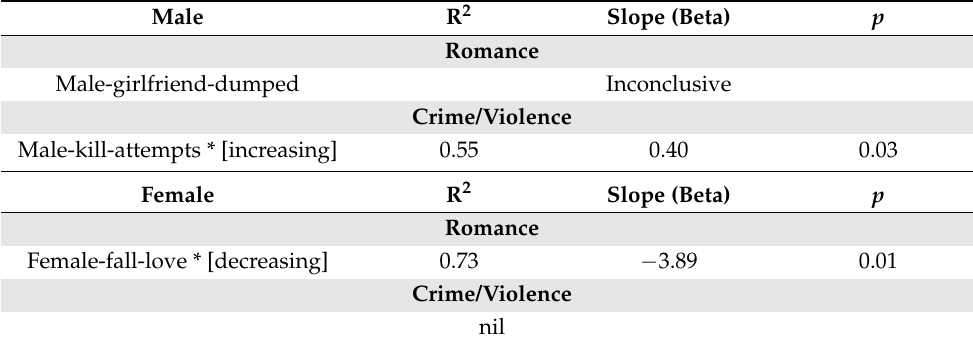
Table 2. Linear regression analysis of path weight regressed on decade. * p < 0.05.